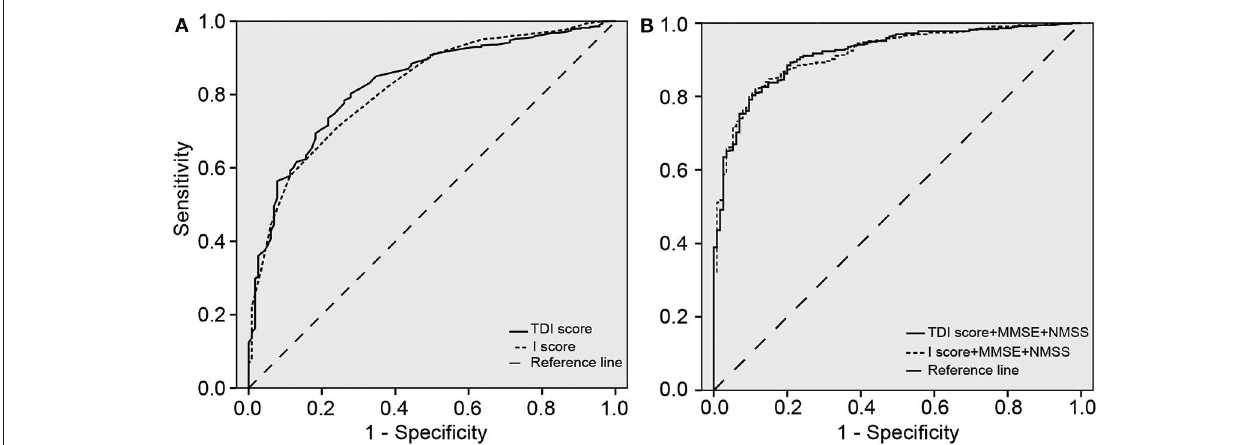
FIGURE 1 | Receiver operating characteristic (ROC) curves. (A) Relating sensitivity and specificity for olfactory threshold, discrimination, and identification (TDI) and I scores in differentiating Parkinson’s disease (PD) patients from healthy controls. (B) Relating sensitivity and specificity for olfactory TDI and I scores combining Mini-Mental State Examination (MMSE) and Non-Motor Symptom Scale (NMSS) in differentiating PD patients from healthy